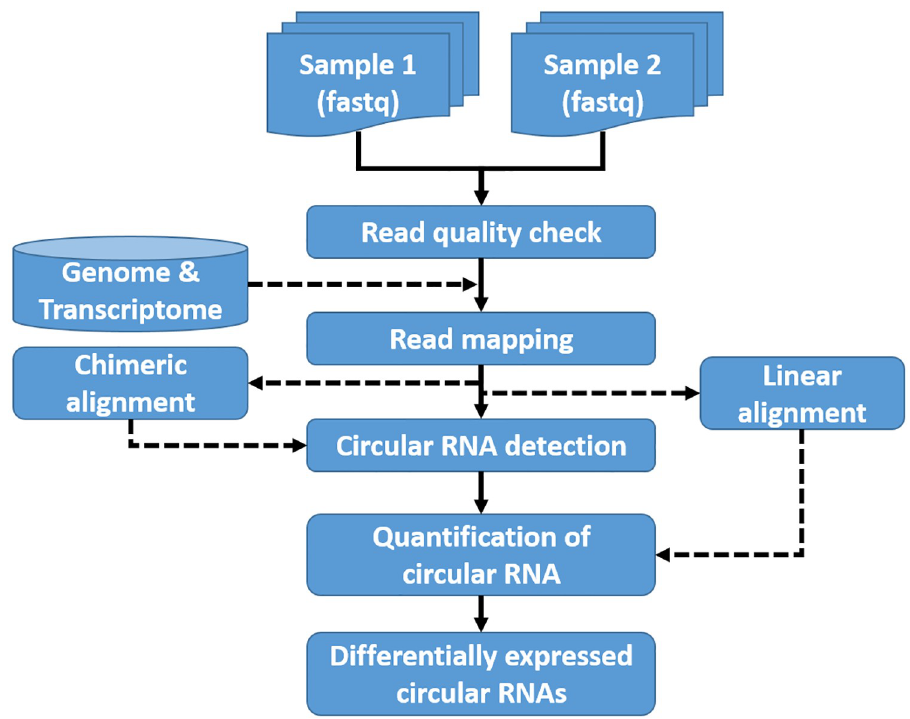
Fig 2. Overall workflow of seekCRIT. seekCRIT takes raw sequence files in fastq format to detect differentially expressed circRNAs.